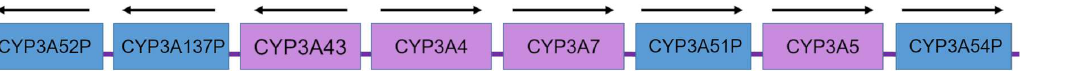
Figure 1. An outline of the human cytochrome P450 3A ( CYP3A ) locus on chromosome 7. Arrows indicate the orientation of open reading frames of genes. P: CYP3A pseudogenes [22]. According to mass spectrometric analysis, proportions of proteins CYP3A4, CYP3A5, CYP3A7, and CYP3A43 in the total amount of CYP3A proteins are on average 85.4%, 5.4%, 3.4% and 5.8%, respectively [23]. CYP3A isoenzymes are expressed mainly in the liver and